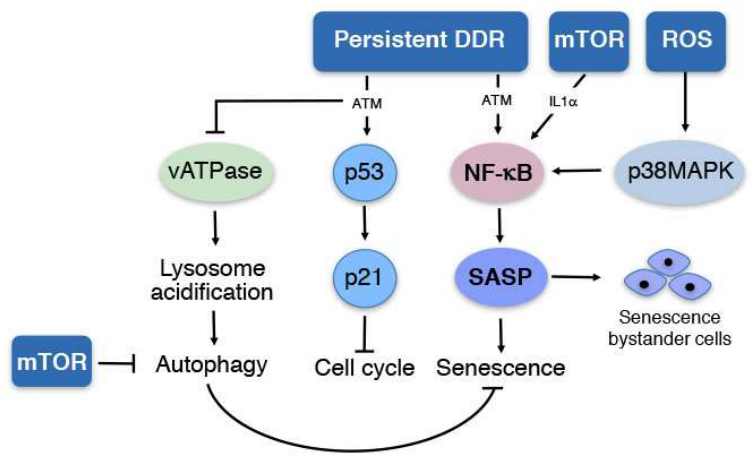
Figure 1. Molecular pathways involved in senescence. Persistent DNA damage response (DDR) activates the ATM/p53/p21 pathway to stop the cell cycle, while preventing lysosomal acidification that inhibits autophagy, and activating NF- κ B that induces senescence associated secretory phenotype (SASP). mTOR and reactive oxygen species (ROS) can induce senescence by DDR-independent mechanisms through the p38MAPK/NF- κ B/SASP pathway. mTOR can also inhibit autophagy by a NF- κ B-independent mechanism to induce senescence. Altogether, cell cycle arrest, reduced autophagy, and secretion of SASP components mediate vascular dysfunction and accelerated aging.